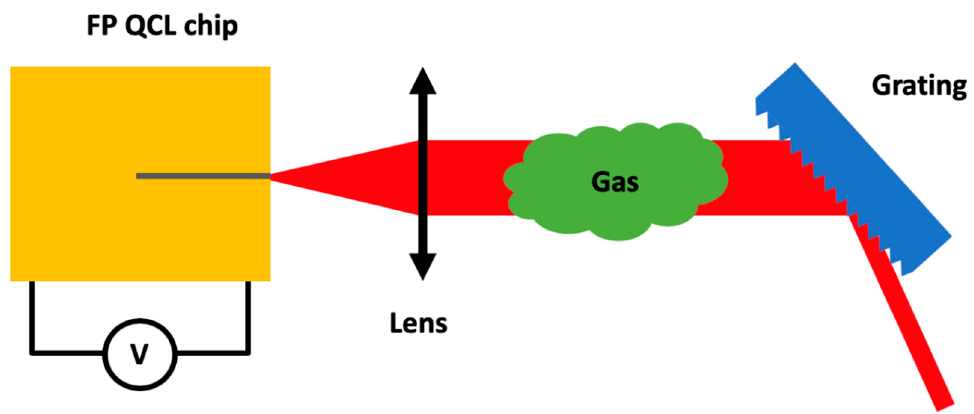
Figure 9. Schematic of an External Cavity Quantum Cascade Laser—Voltage Intracavity Sensing for gas detection in front facet Littrow configuration. Note that, in this case, no detection system is needed as the cavity is the light source and the detector at the same time.